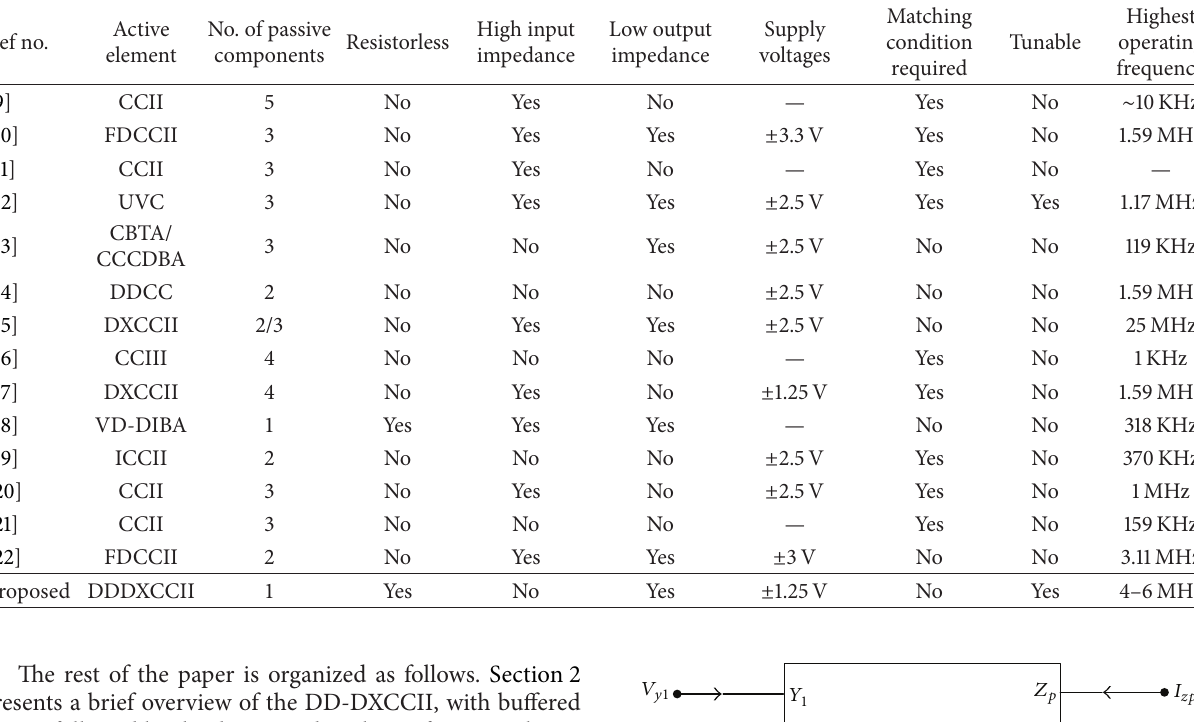
Table 1: Comparison of single active element based proposed and existing first-order circuits. Ref no.